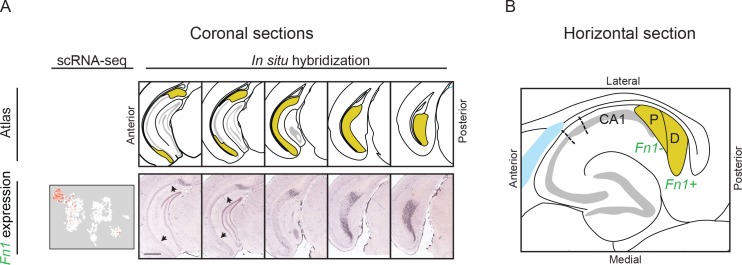
Proximal and distal subiculum, as viewed through coronal and horizontal sections.(A) Expression of the distal marker Fn1, shown in coronal sections, as in Figure 3. Arrows denote extent of CA1, as assessed through atlas images and tightly packed cell body layer. Note in this plane of sectioning, Fn1 expression is strongest in posterior sections. Also note that in all sections Fn1 expression is spatially removed from CA1. Scale bar: 1 mm. (B) Schematized expression of Fn1 in a horizontal section, dividing the subiculum into proximal (‘P’) and distal (‘D’).